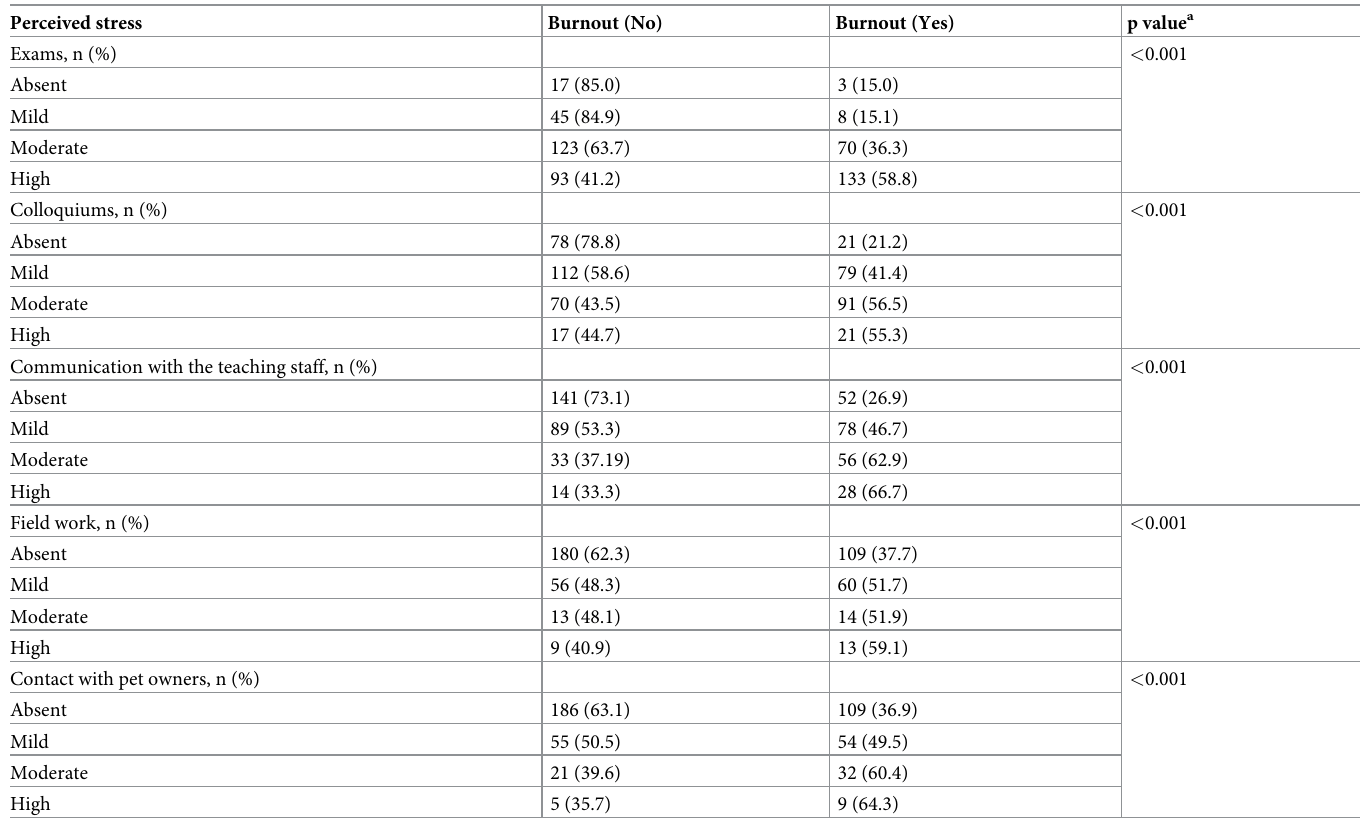
Table 3. Perceived stressful influence of study activities with regard to burnout among Belgrade veterinary